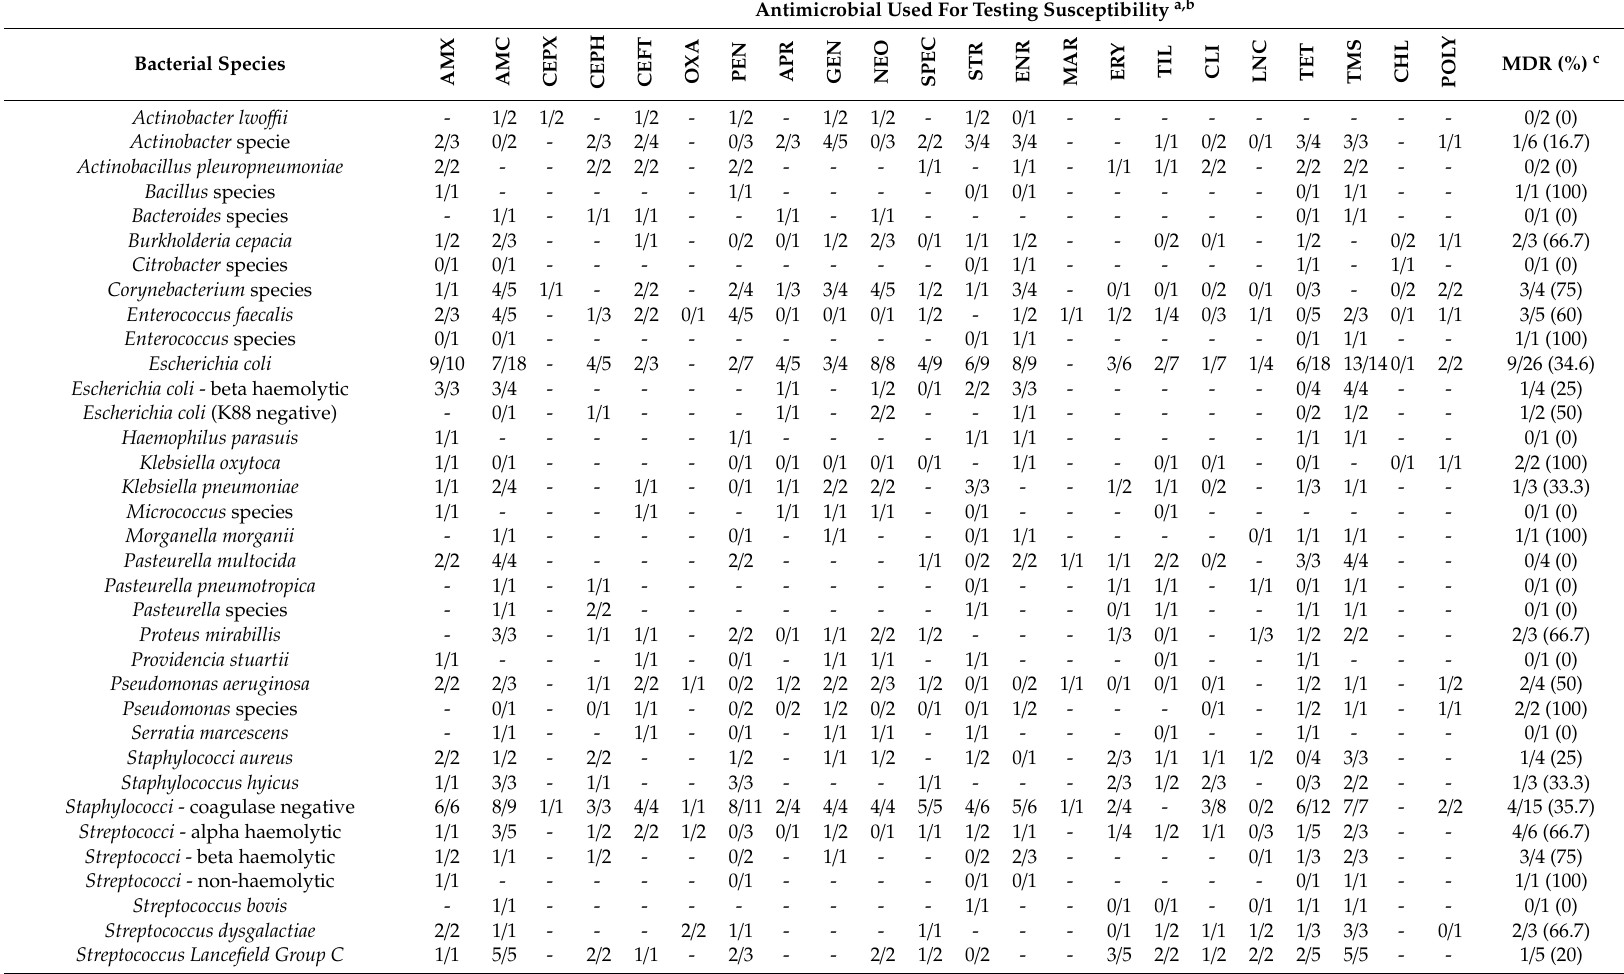
Table 3. Antimicrobial susceptibility and multidrug resistance for tested bacteria isolated from submissions for New Zealand pigs for the period June 2003 to February